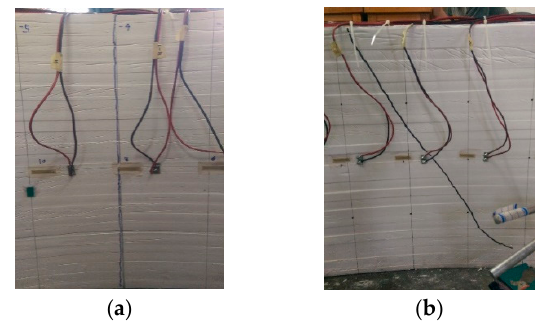
Figure 20. Crack form. ( a ) Longitudinal cracks; ( b ) Diagonal cracks.